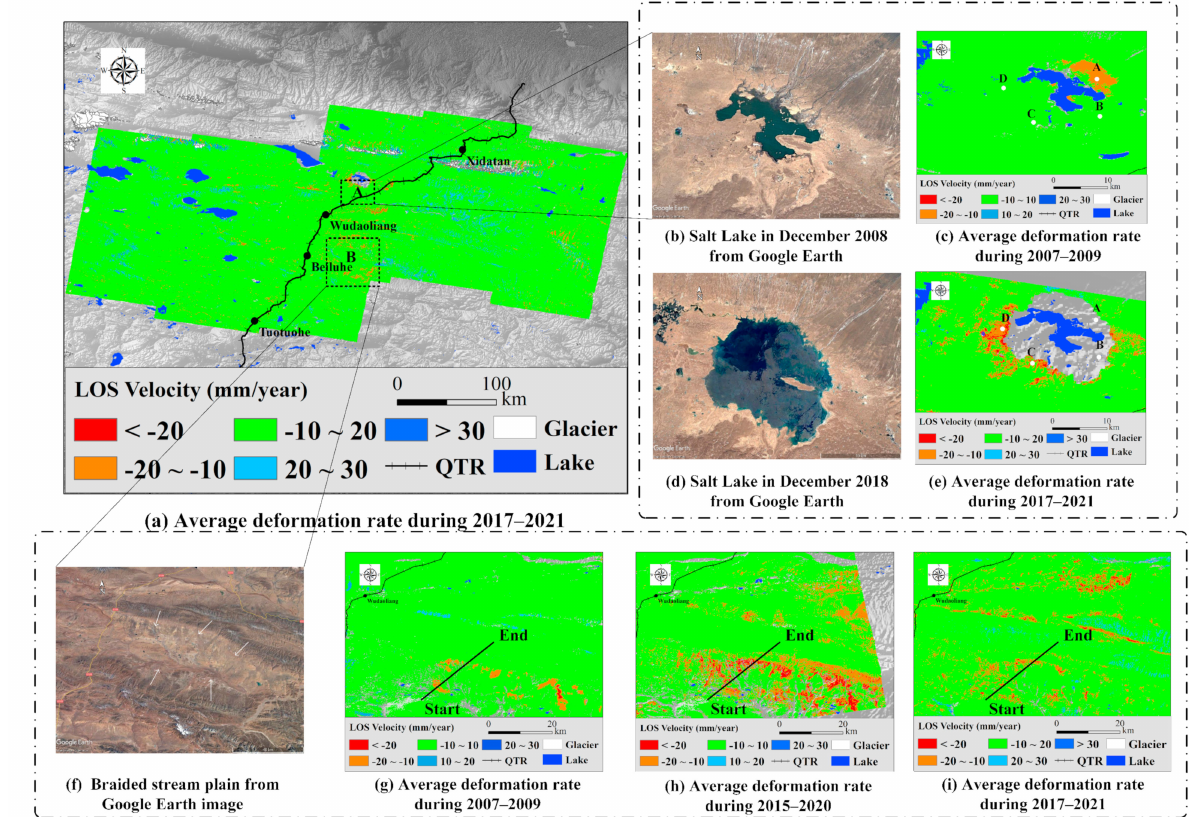
Figure 4. Permafrost evolution in two typical areas, Salt Lake and braided stream plain. ( a ) Average deformation rate during 2017–2021. ( b ) Salt Lake in December 2008 from Google Earth. ( c ) Average deformation rate during 2007–2009. ( d ) Salt Lake in December 2018 from Google Earth. ( e ) Average deformation rate during 2017–2021. ( f ) Braided stream plain from Google Earth image. ( g ) Average deformation rate during 2007–2009. ( h ) Average deformation rate during 2015–2020. ( i ) Average deformation rate during